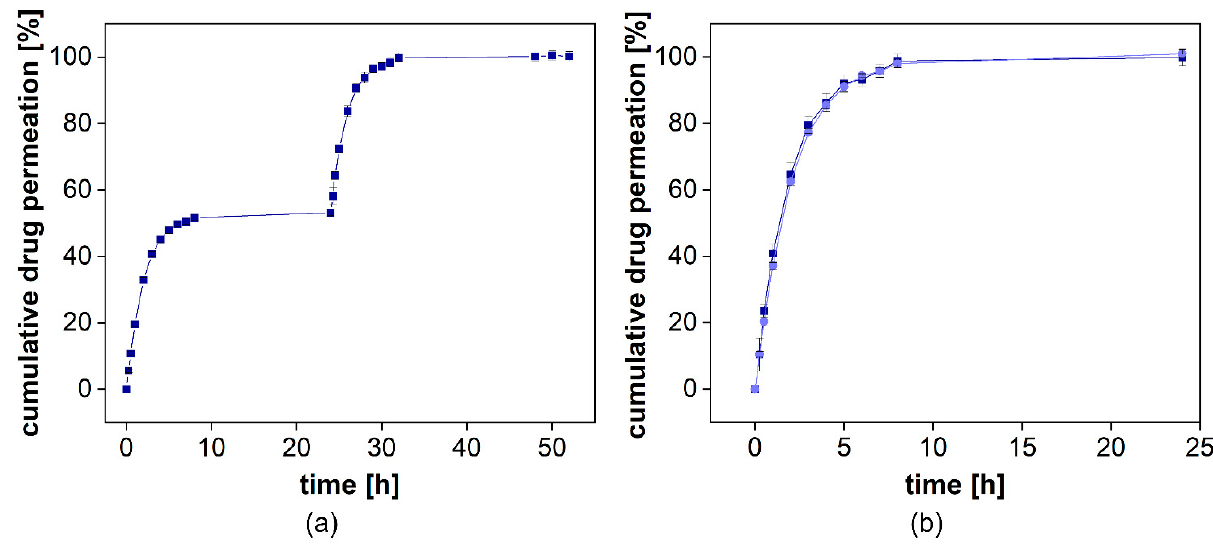
Figure 8. Cumulative release of diclofenac-DEA from Voltaren Emulgel ® with diclofenac-DEA solution spiked into the donor compartment after 24 h. Mean ± SD is presented ( n = 3). On the left, the release profile over 48 h is presented ( a ). On the right, the overlay of the initial release and the permeation profile are provided ( b ).